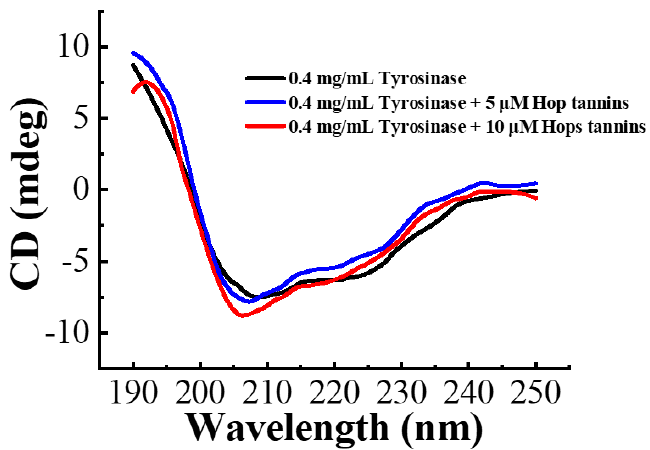
Figure 2. CD spectrum of tyrosinase before and after binding with hop tannins.